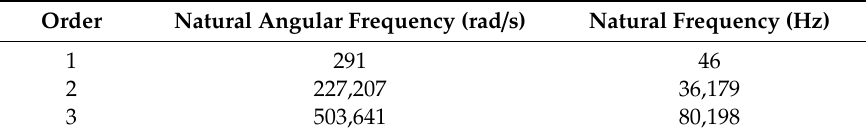
Table 2. First three order natural frequency under no-load state. Order Natural Angular Frequency (rad / s) Natural Frequency